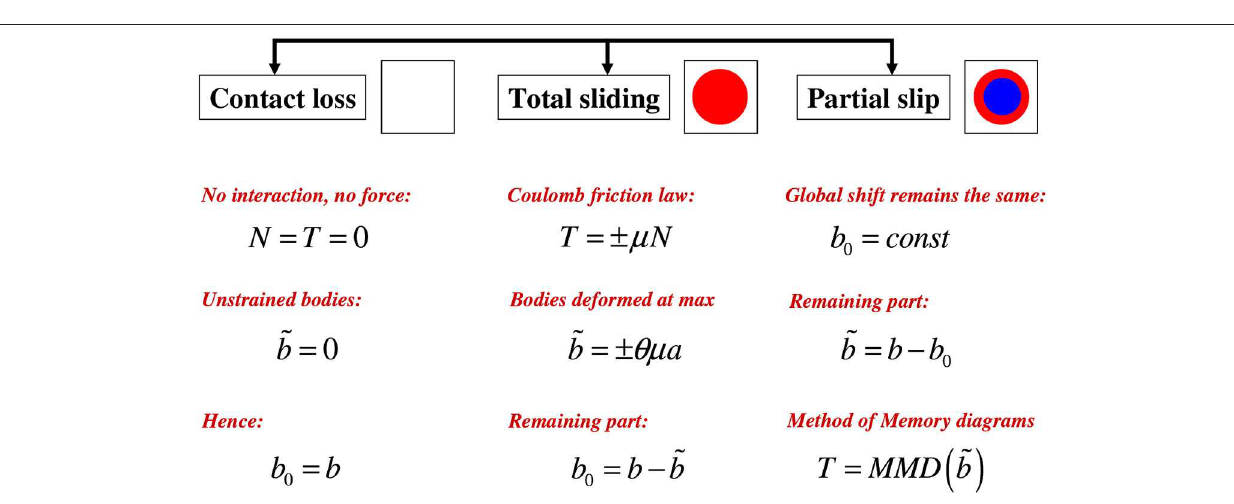
quasi-static character of description and generally